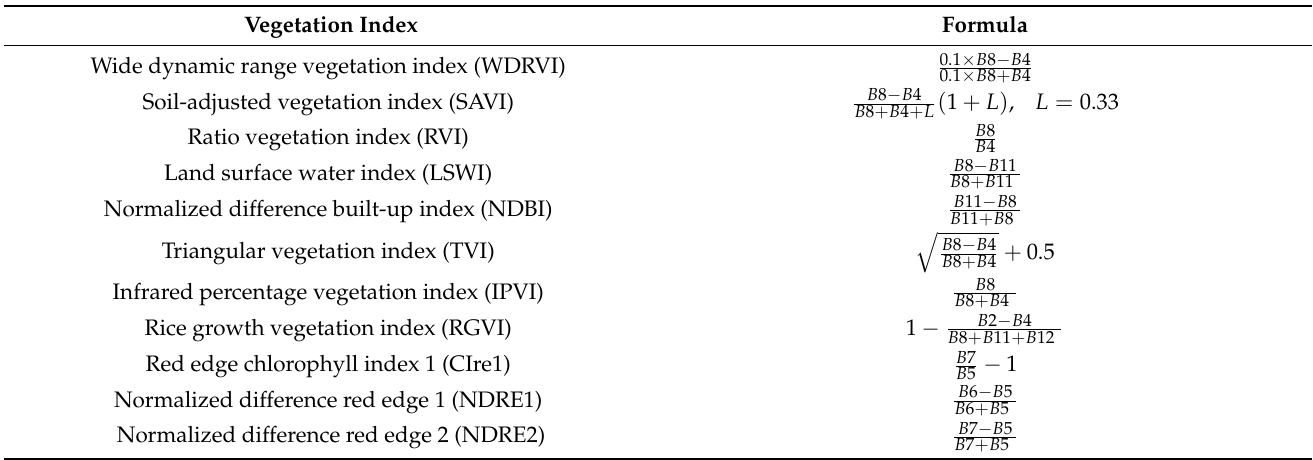
Table A5. Cont. Vegetation Index Formula